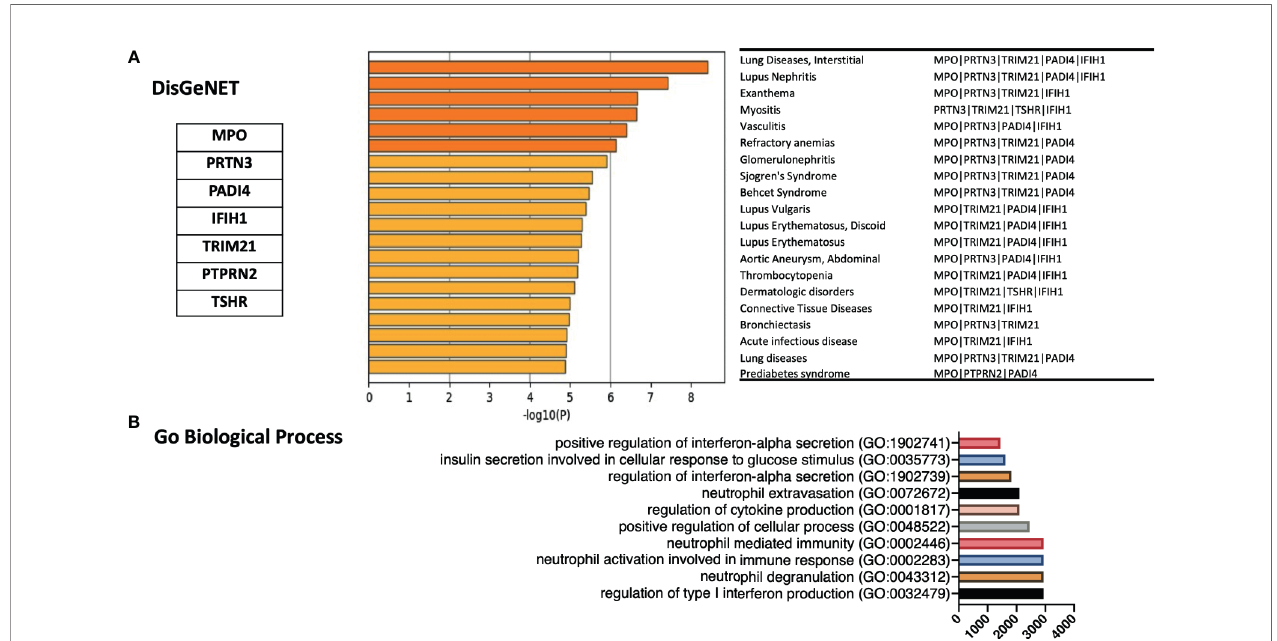
FIGURE 3 | Gene ontology enrichments identi fi ed in the DisGeNET and Gene Ontology biology process databases. (A) Summary of enrichment of DisGeNet category of Metascape. Terms with a p-value <0.01, a minimum count of 3, and an enrichment factor >1.5 (the enrichment factor is the ratio between the observed counts and the counts expected by chance) are collected and grouped into clusters based on their membership similarities. The top few enriched clusters (one term per cluster) were presented. (B) Top 10 categories of the GO biological processes. GO analysis associated with the top seven differentially expressed autoantigens was performed using Enrichr. Bar lines represent cumulative score for the 10 top-ranked categories of GO biological processes. Combined score is computed by taking the log of the p-value from the Fisher exact test and multiplying that by the z score of the deviation from the expected rank.